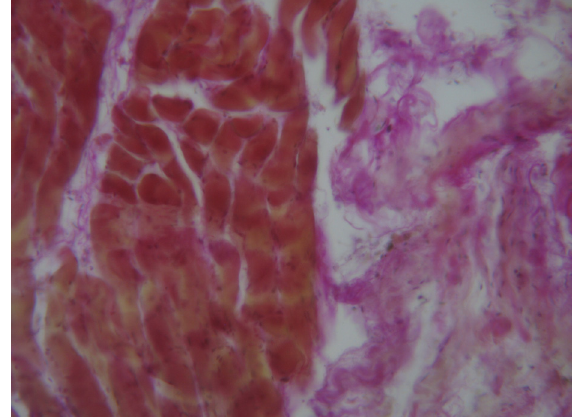
Figure 8. Microstructure of an ear tissue sample after processing with the ferment preparation Protepsin, magn. 200 (after 2.5